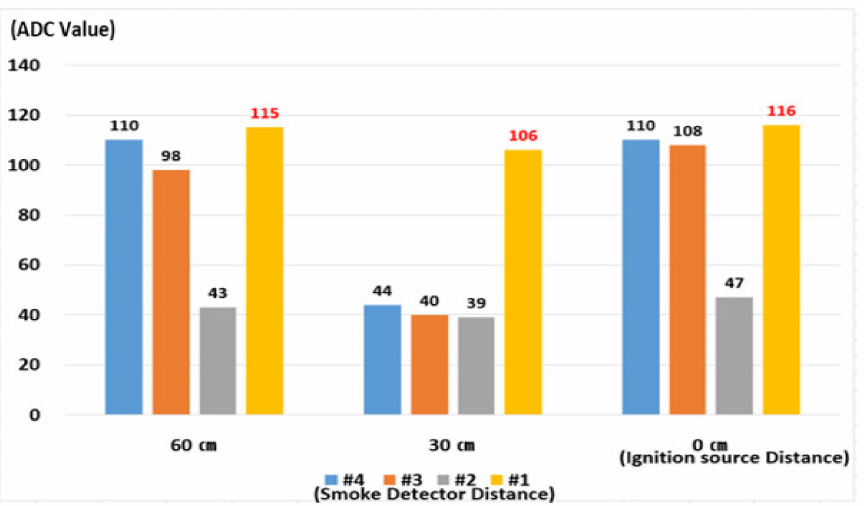
Figure 19. Concentration value comparison test result by ignition source